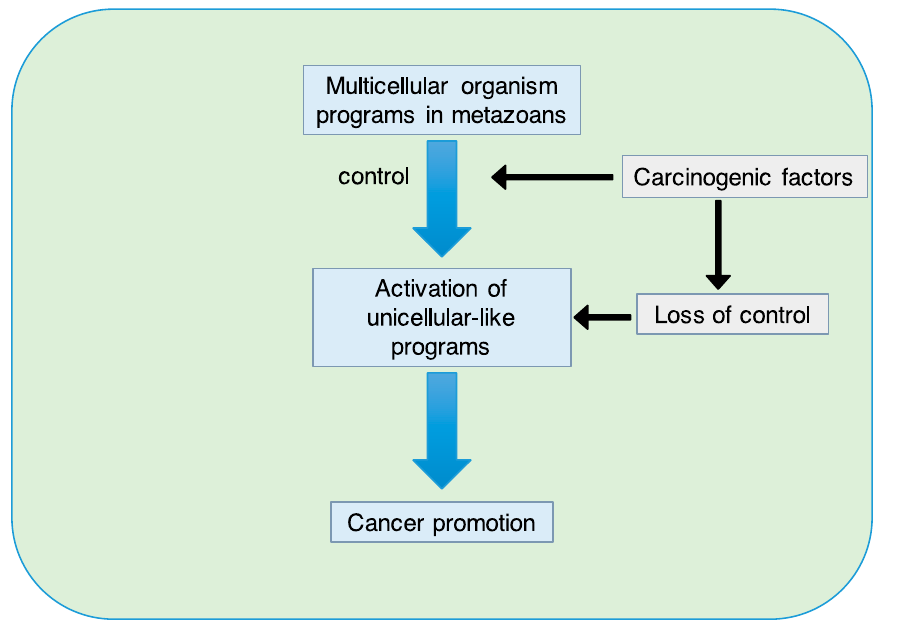
Figure 3. When properly functioning, multicellular programs are believed to be oncosuppressive. The loss of control over these programs caused by cancer-promoting factors may result in the activation of unicellular-like programs that promote